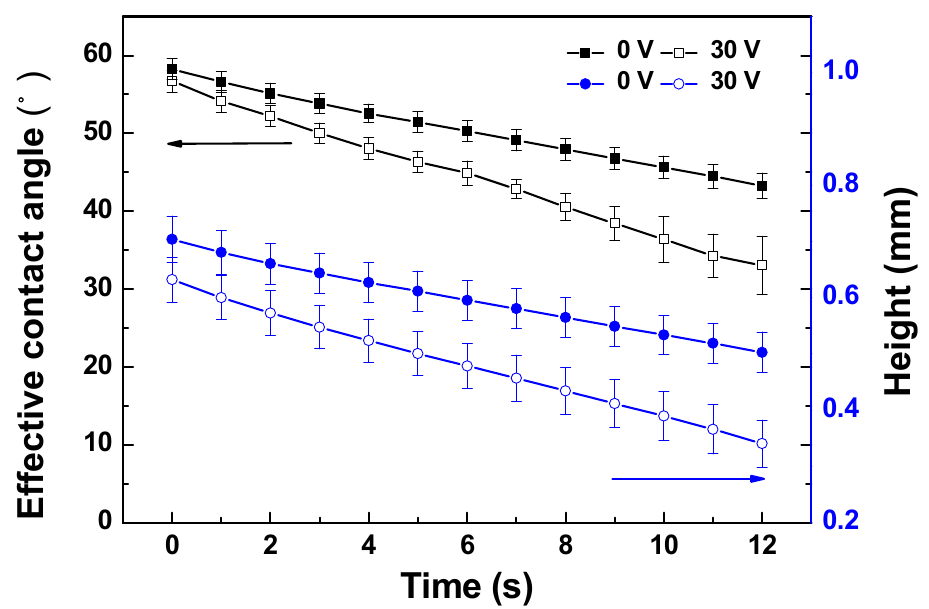
Figure 5. The effective contact angle and droplet height change of PANI/EG composite membranes over time with and without applied potential (30 V).